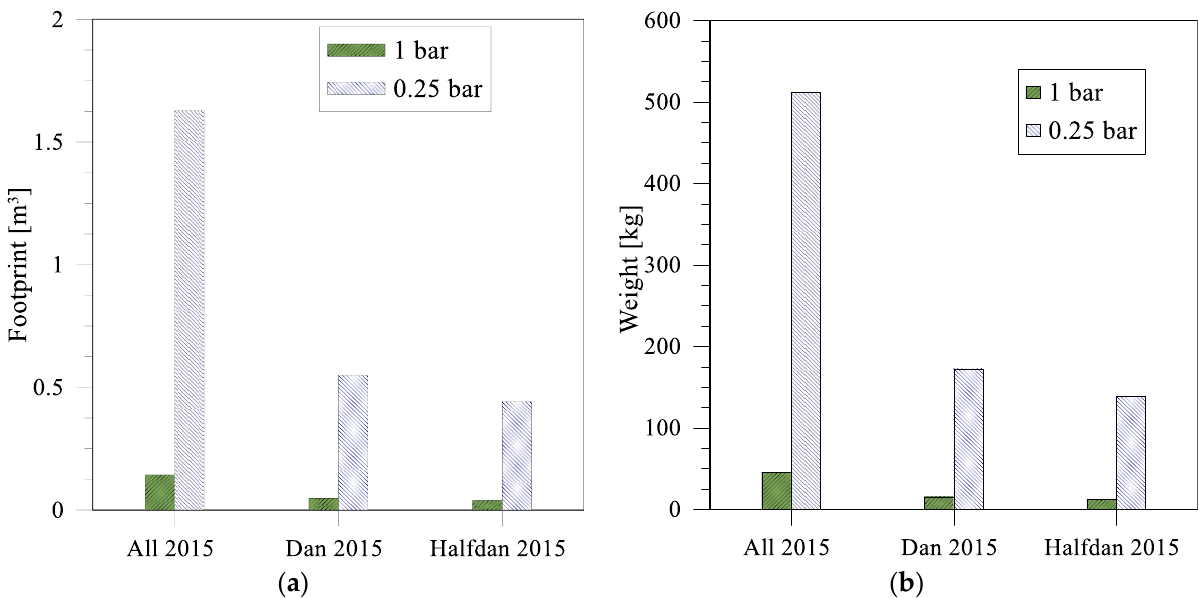
Figure 8. Membrane footprint ( a ) and weight ( b ) required to convert the daily volume of PW in the Danish part of the North Sea into emulsions for injection purpose.